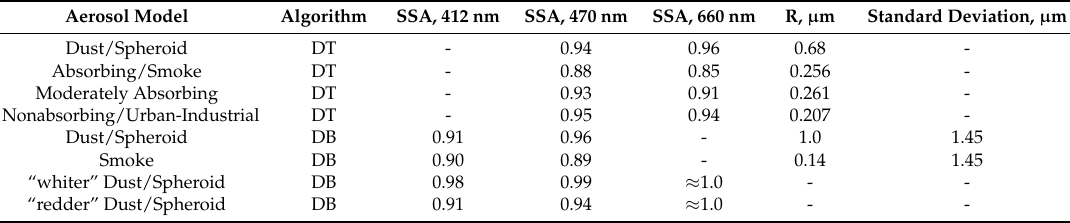
Table 1. List of typical optical parameters in aerosol models used in MODIS Dark Target (DT) and Deep Blue (DB) algorithms [10,25]. The DT aerosol model varies with aerosol loading and the case of AOD 550 = 0.5 is presented here; R denotes the effective radius in the DT model, and for DB it is the mean radius; since information of Collection 6 DB aerosol model is not available, the original version is used for reference. SSA, single scattering